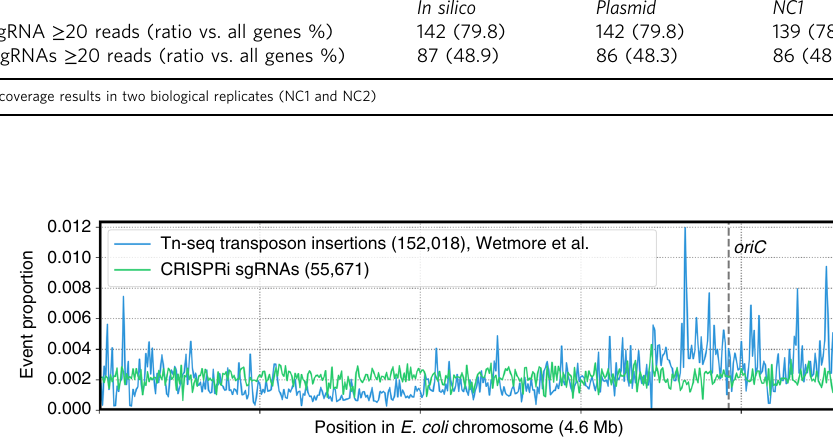
Table 1 Summary of genome-wide sgRNA library metrics 4140 protein-coding genes In silico Genes with at least 1 sgRNA ≥ 20 reads (ratio vs. all genes %)